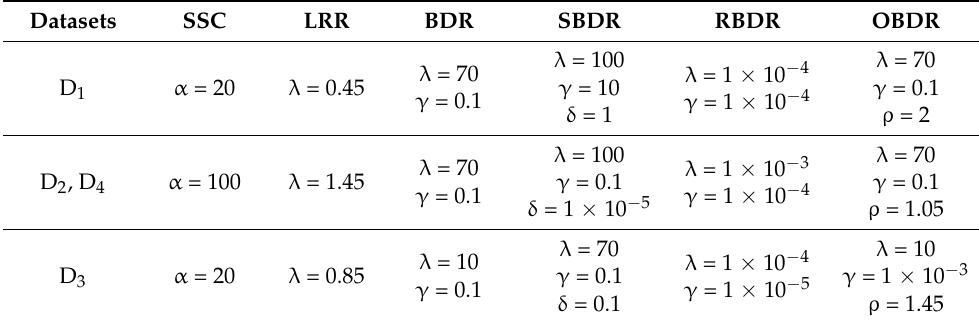
Table 2. The parameter values used in each